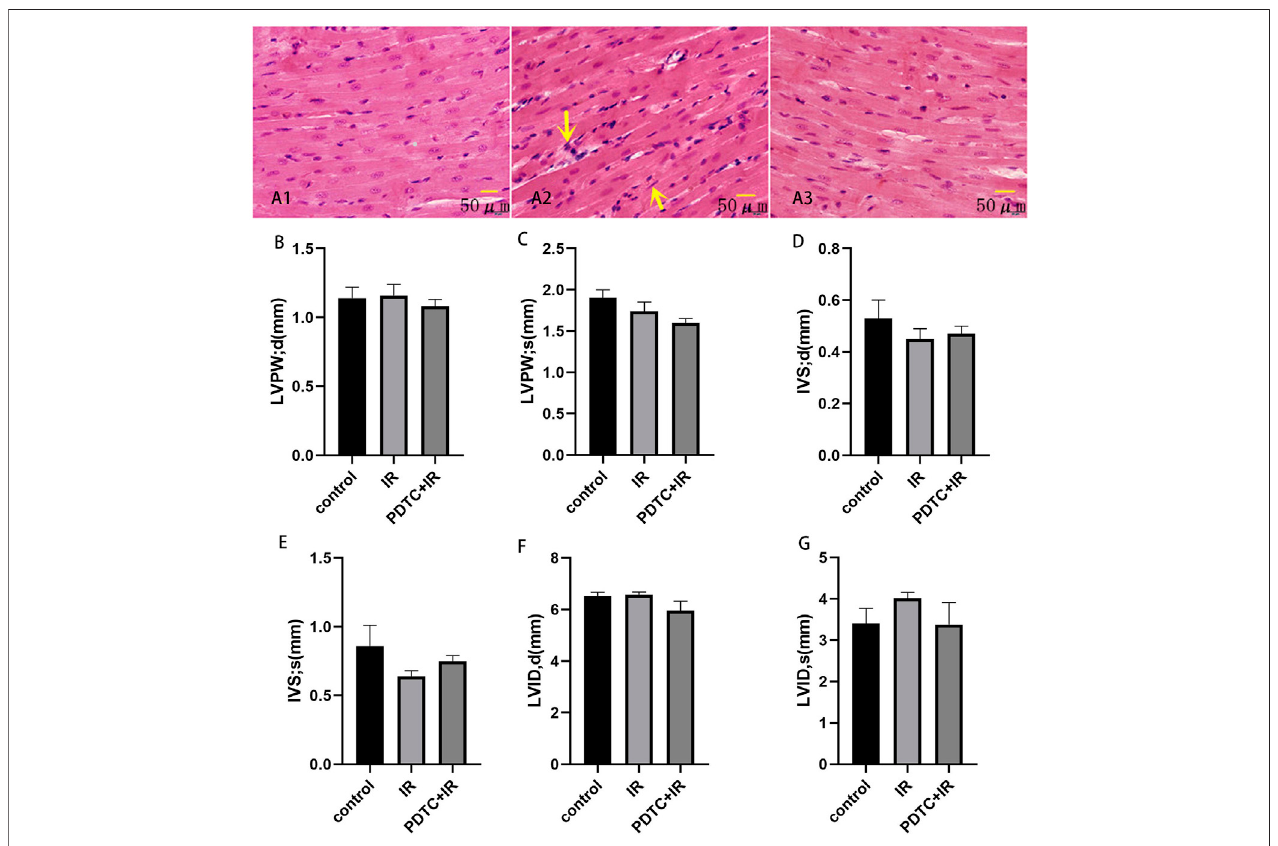
FIGURE 3 | Effects of PDTC on myocarditis reaction (n = 5). Transverse section in the cardiac muscles of rats via HE staining for the observation of cardiac injury (×200). (A1) : controlgroup; (A2) :irradiation group; (A3) : PDTC+irradiation group. Arrows wereabnormalcellsin fi ltration. (B,C) showthethicknessofLVPWat diastole and systole. (D,E) show the thickness of IVS at diastole and systole. (F,G) show LVID at diastole and systole.